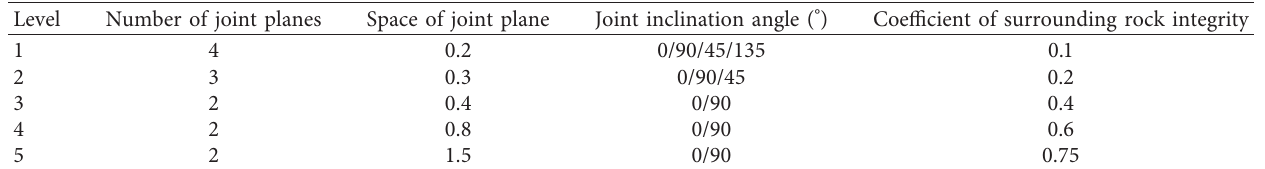
Table 2: Parameter values of each level of factor C.